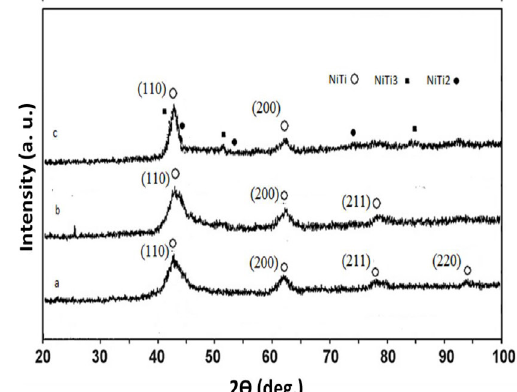
Fig. 1. XRD patterns of milled powder (a), sintered specimen at 800°C for 30 min (b), and the sintered specimen at 800°C